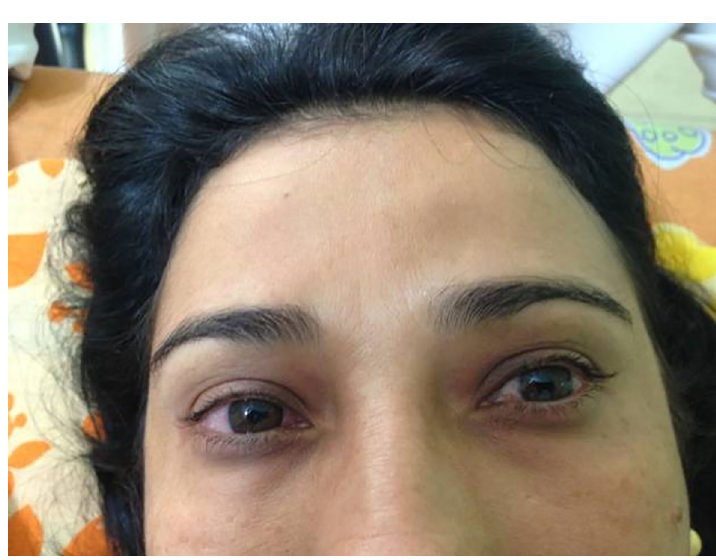
Figure 1A. Hyperemia with periorbital edema.